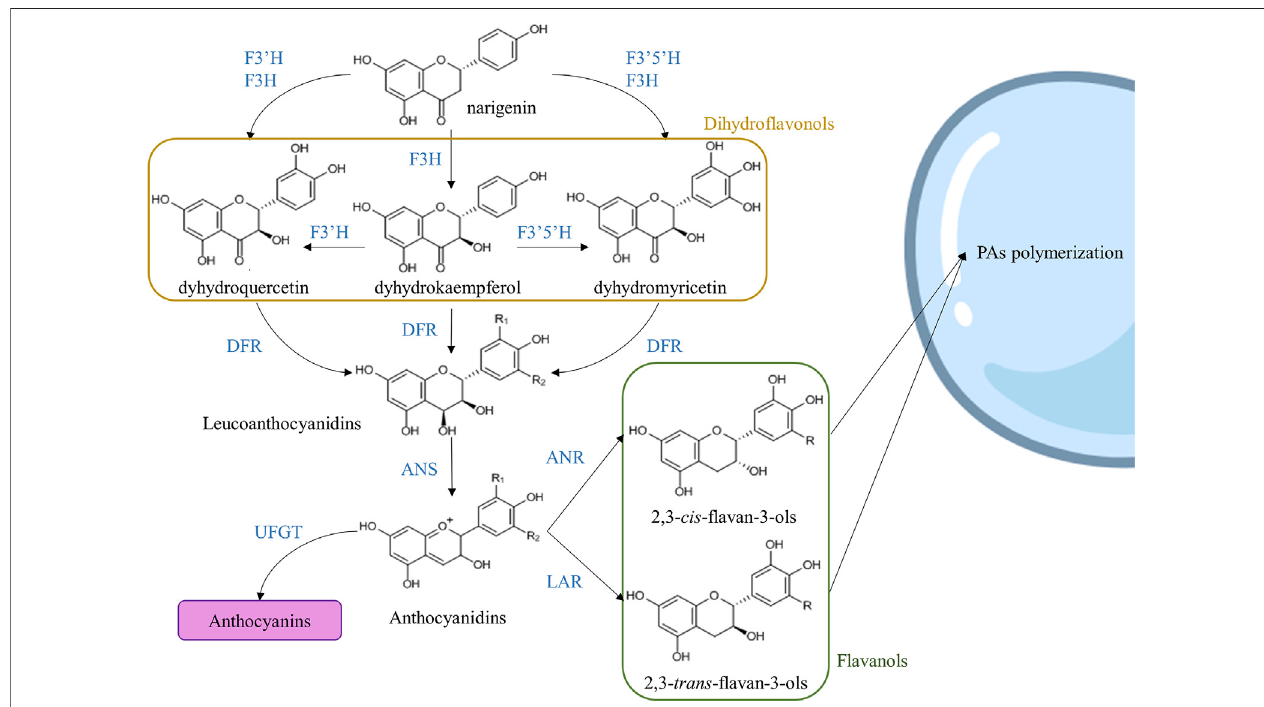
FIGURE 3 | Simpli fi ed fl avonoid pathway. One branch of this pathway yields fl avanols that can be transported to the vacuole by several proposed mechanisms. Abbreviations: fl avonoid 3-hydroxylase (F3H), fl avonoid 3 ′ -hydroxylase (F3 ′ H), fl avonoid 3 ′ 5 ′ -hydroxylase (F3 ′ 5 ′ H), dihydro fl avonol 4-reductase (DFR), anthocyanidin synthase(ANS),UDP-glucose fl avonoid3-O-glucosyltransferase(UFGT),anthocyanidinreductase(ANR),andleucoanthocyanidinreductase(LAR).Modi fi